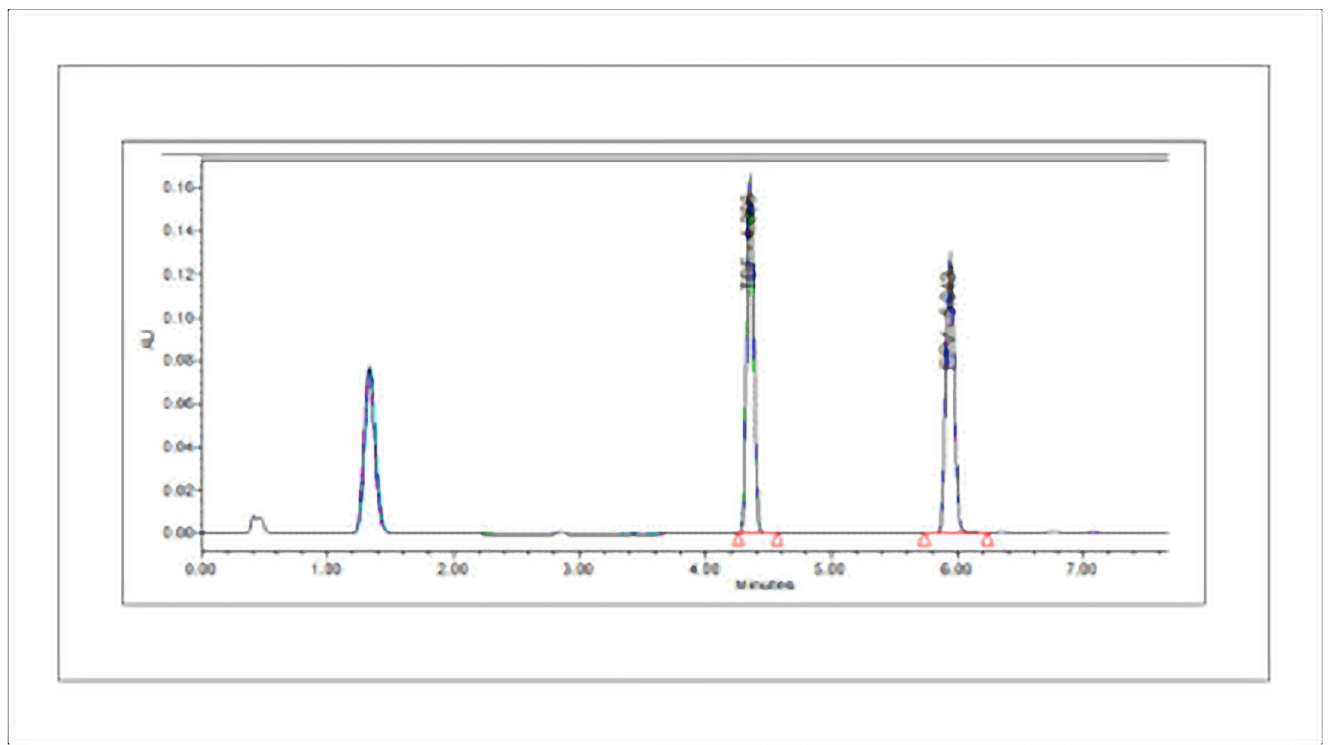
RSD was determined to be 0.497 (NMT 2.0%). The chromatograms obtained for the precision